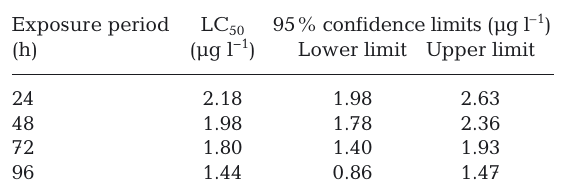
Table 1. Median lethal concentrations (LC 50 ) of chlorpyrifos to juveniles of Litopenaeus vannamei tested during different